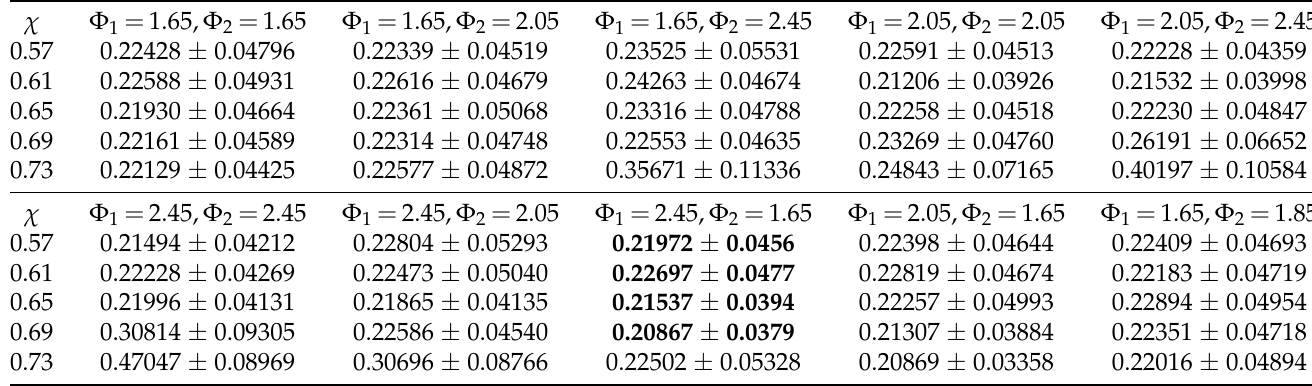
Table 5. The values of mean and standard deviation of f 4 obtained using PSO with I = 100, D = 80, (cid:96) = 12, n = 25 for 50 calculations with the metric d 2